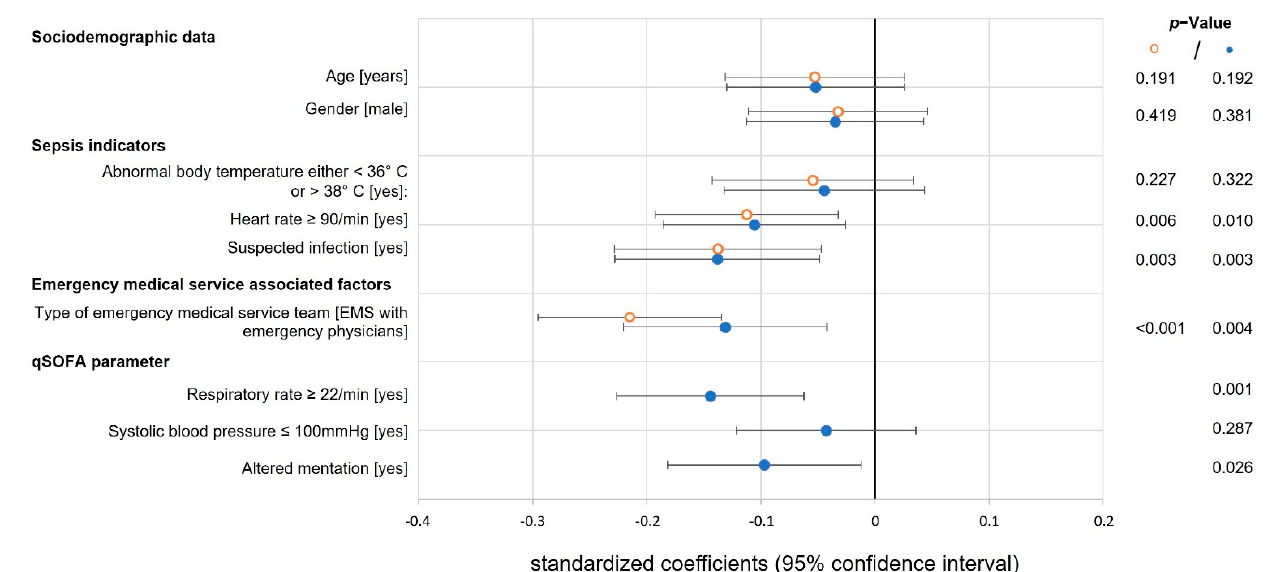
Figure 3. Time to antibiotics. The forest plot shows the standardized coefficients with 95% CI (x-axis) and p -values for each covariable regarding the primary endpoint ‘time to antibiotics’ of two multiple linear regression models: model without qSOFA (orange ᵒ dot) and model with additional qSOFA parameters (blue • dot); time is logarithmized; the vertical solid line marks a standardized coefficient of zero, a shift to the right indicates a prolonged and to the left side a shortened ‘time to antibiotics’; qSOFA: quick sequential organ failure assessment.